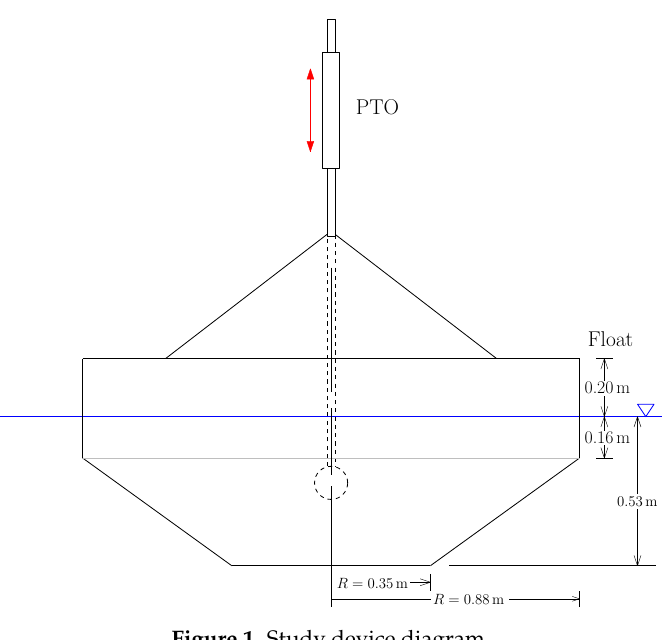
Figure 1. Study device diagram. Table 1. Model-scale wave energy converter (WEC) physical